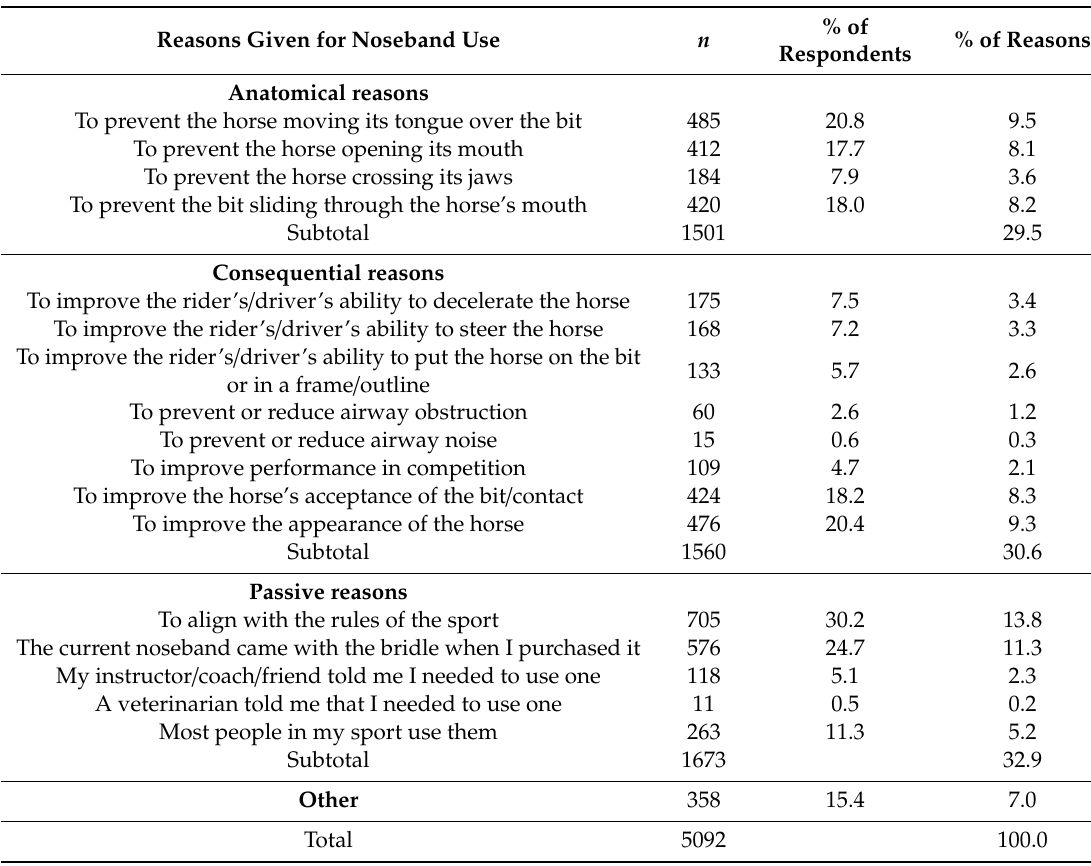
Table 3. The distribution of reasons ( n = 5092) that respondents ( n = 2332) o ff ered for use of nosebands. The percentage of all respondents using nosebands who selected a particular value are presented in the third column. The percentage of all reasons given by respondents (independent of the respondent) are presented in the fourth